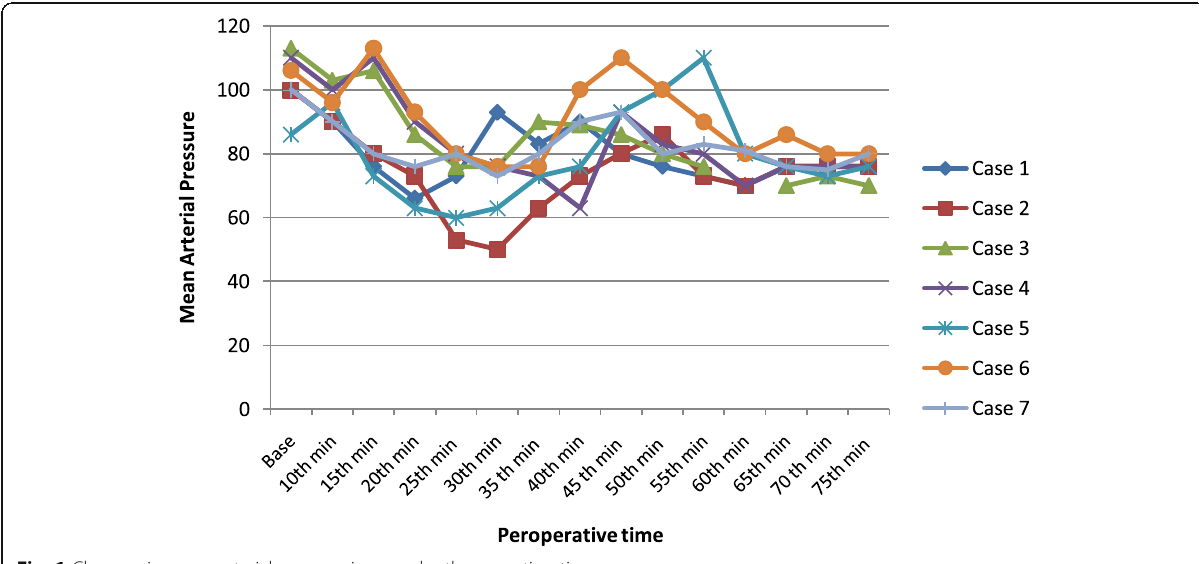
Fig. 1 Changes in mean arterial pressure in cases by the operation